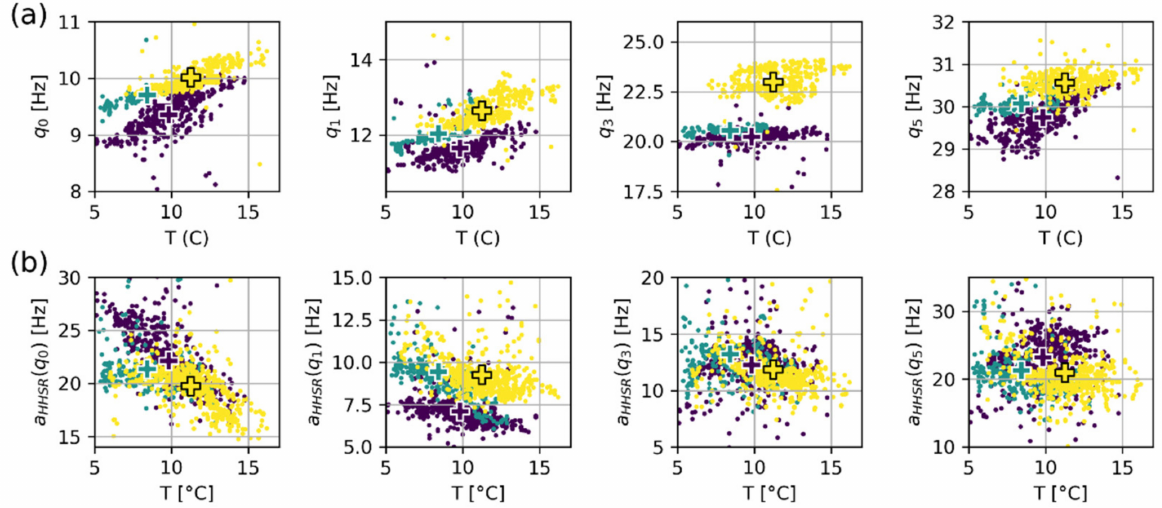
Figure 12. HHSR peak frequencies q n ( a ) and corresponding peak amplitudes a HHSR ( q n ) ( b ) as a function of air temperature. Initial stage before bolting is shown with dark blue dots. Stage between i 1 and i 2 is shown in green. Final stage after i 2 is shown with yellow dots. Centroid of each phase is pointed with a colored cross. Days with drilling works have been removed from the